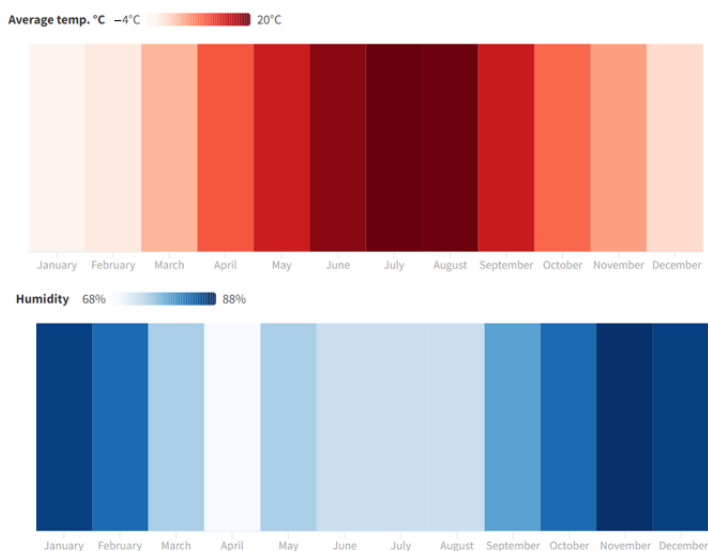
Figure 3. Annual average temperature and humidity in the region analysed.